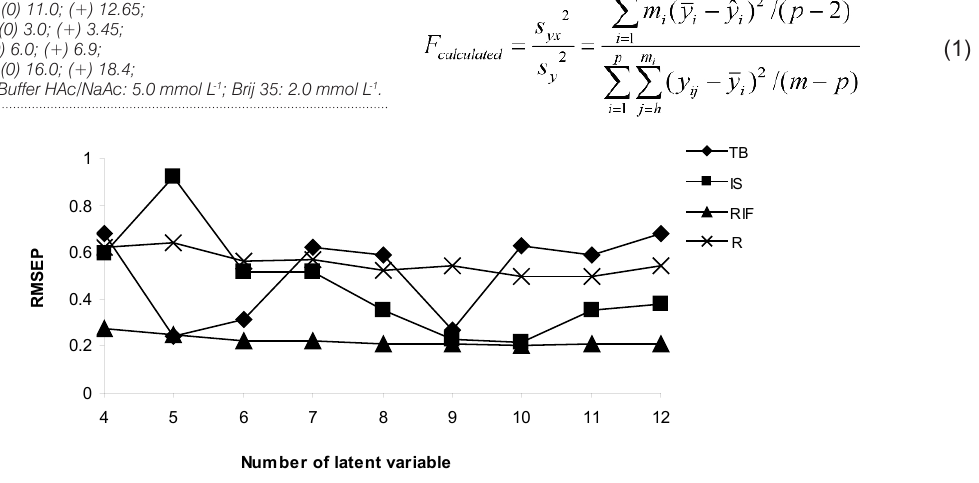
Figure 4. RMSEP scatter diagram of latent variables for ETB, ISO, RIF and